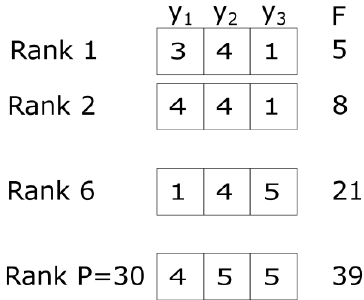
Figure 1. Initial randomly population generated by Shuffled Frog Leaping Algorithm (SFLA).